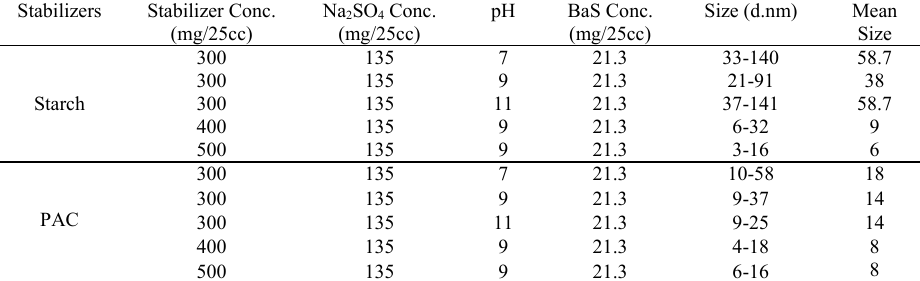
J Nanostruct 9(2): 316-325, Spring 2019